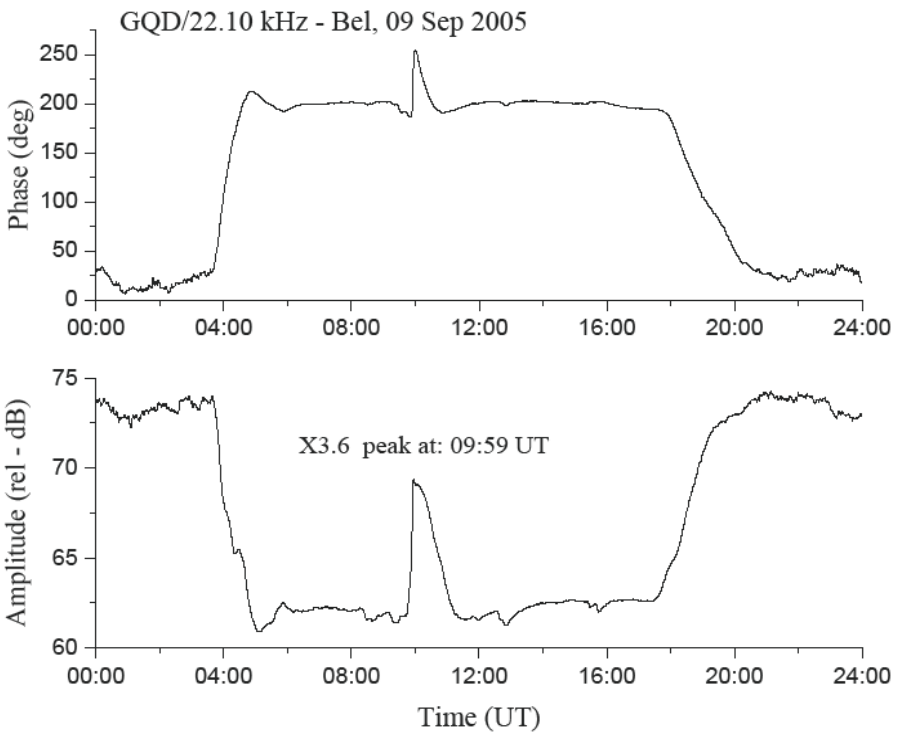
Figure 2. Example of VLF signal variations of GQD signal recorded at Belgrade station due to SF event X3.6-class at 09 Oct 2005 (start 09:42, peak 09:59, end 10:08 UT). At peak time the measured variations of amplitude and phase ∆ A = 7.25 dB and ∆ P = 50 deg,